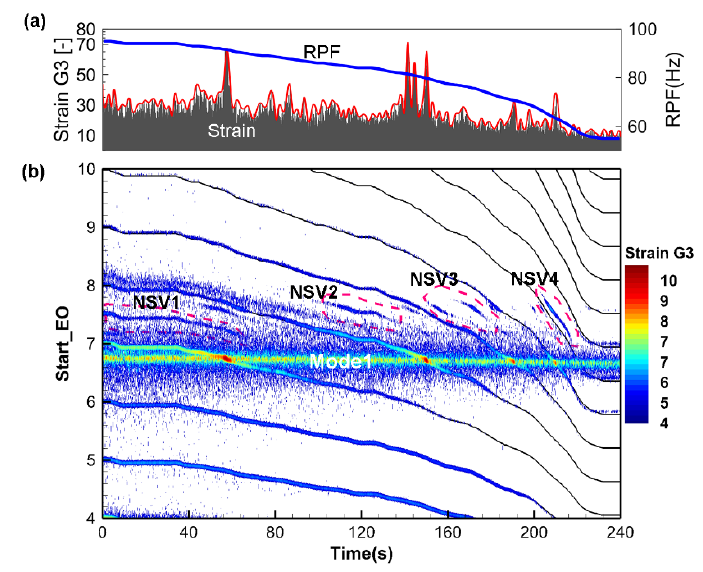
Figure 8. Blade vibration measured by Strain Gauge G3 during Speed Ramp: ( a ) time domain signal; ( b ) time-frequency spectrum based on STFT.